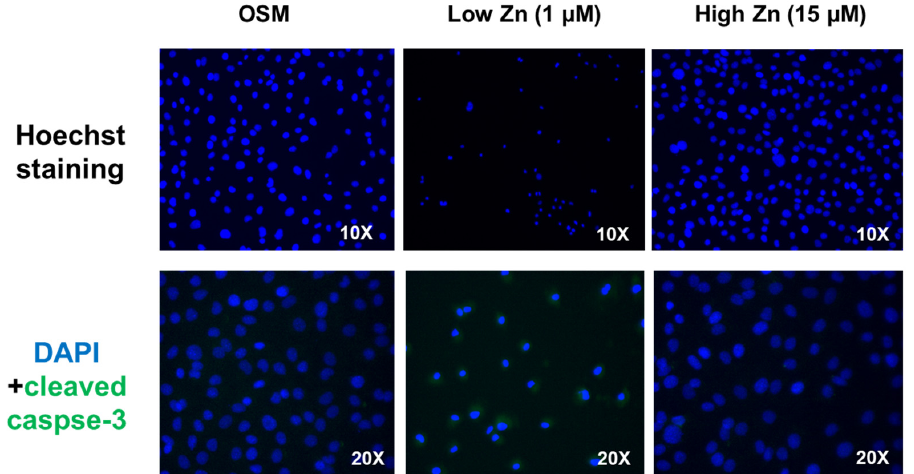
Figure 6. Osteoblast apoptosis observed using Hoechst staining and c-Caspase-3. MC3T3-E1 cells were treated with low or high Zn for 24 h. The apoptotic cells exhibited chromatin condensation, nuclear fragmentation and apoptotic bodies.